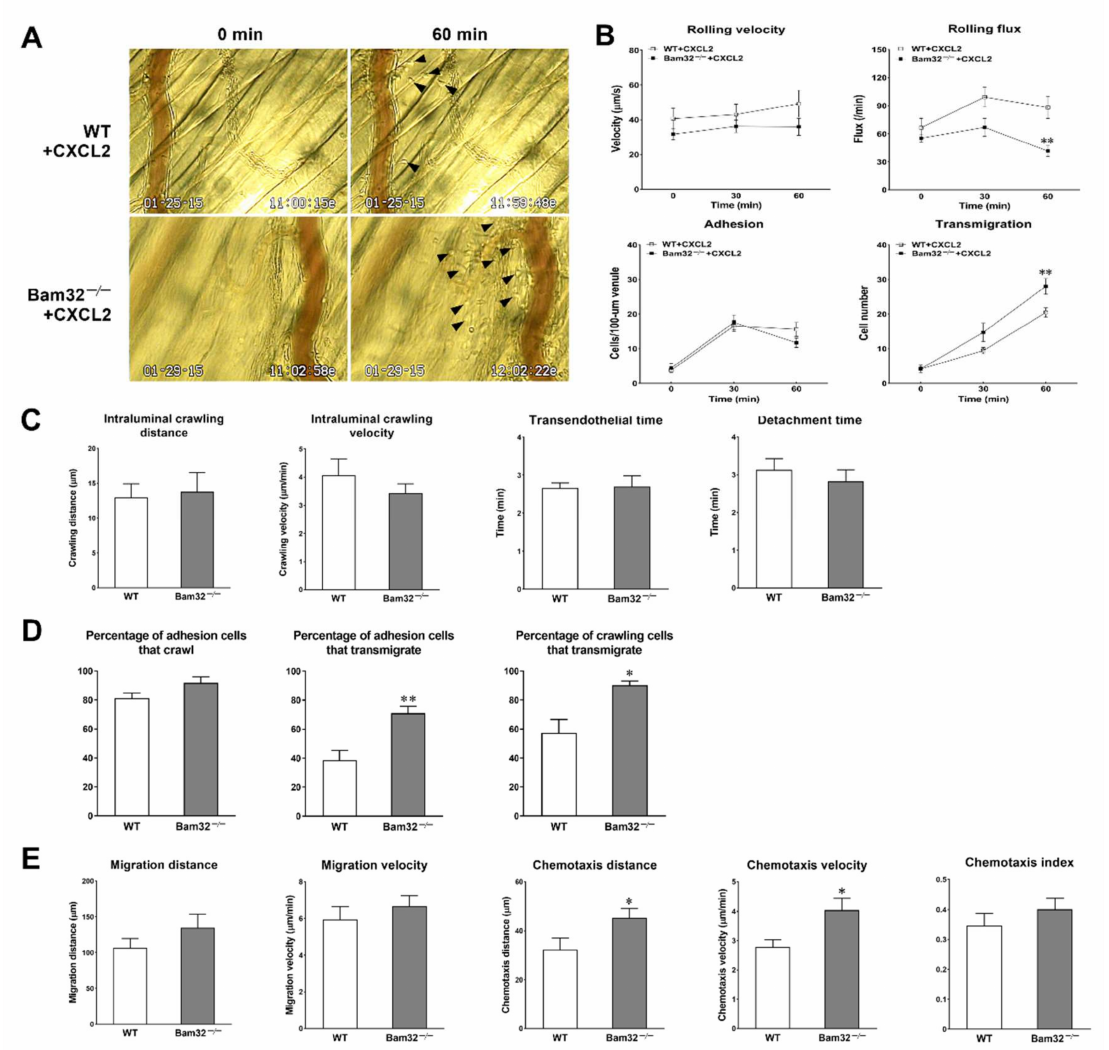
Figure 1. Effect of Bam32 deficiency on CXCL2-induced neutrophil recruitment in the mouse cremaster muscle. ( A ) Representative micrographs from intravital video microscopy showing a postcapillary venule and the surrounding tissue of the cremaster muscle with transmigrated neutrophils (arrow head) before (0 min) and at 60 min following the placement of CXCL2-containing gel (out of the view, 350- µ m distant from the venule) in wild-type (WT) and Bam32 − / − mice (magnification: 100 × ). ( B ) Intravascular leukocyte rolling velocity, rolling flux, and numbers of adherent neutrophils (cells/100- µ m venule) and emigrated neutrophils (cells/235 × 208 µ m 2 field) before (0 min) and 30 and 60 min after the placement of CXCL2-containing gel on the cremaster muscle of WT and Bam32 − / − mice. ( C ) The crawling distance ( µ m), crawling velocity ( µ m/min), transendothelial time (min), and detachment time (min) during 60-min video recording following the placement of CXCL2-containing gel in WT and Bam32 − / − mice. ( D ) The percentage of adherent cells that crawled on the luminal surface of the endothelium, the percentage of adhesion cells that transmigrated across the endothelium, and the percentage of crawling cells that transmigrated across the endothelium during 60-min video recording following the placement of CXCL2-containing gel in WT and Bam32 − / − mice. ( E ) The migration distance ( µ m), chemotaxis distance ( µ m), migration velocity ( µ m/min), chemotaxis velocity ( µ m/min), and chemotaxis index of neutrophil chemotaxis in extravascular tissue during 60 min following the placement of CXCL2-containing gel on the cremaster muscle of WT and Bam32 − / − mice (averaged from >80 cells). ( B − E ): mean ± SEM of 8 mice per group. * and ** indicate significant differences ( p < 0.05 and p < 0.01, respectively) from WT